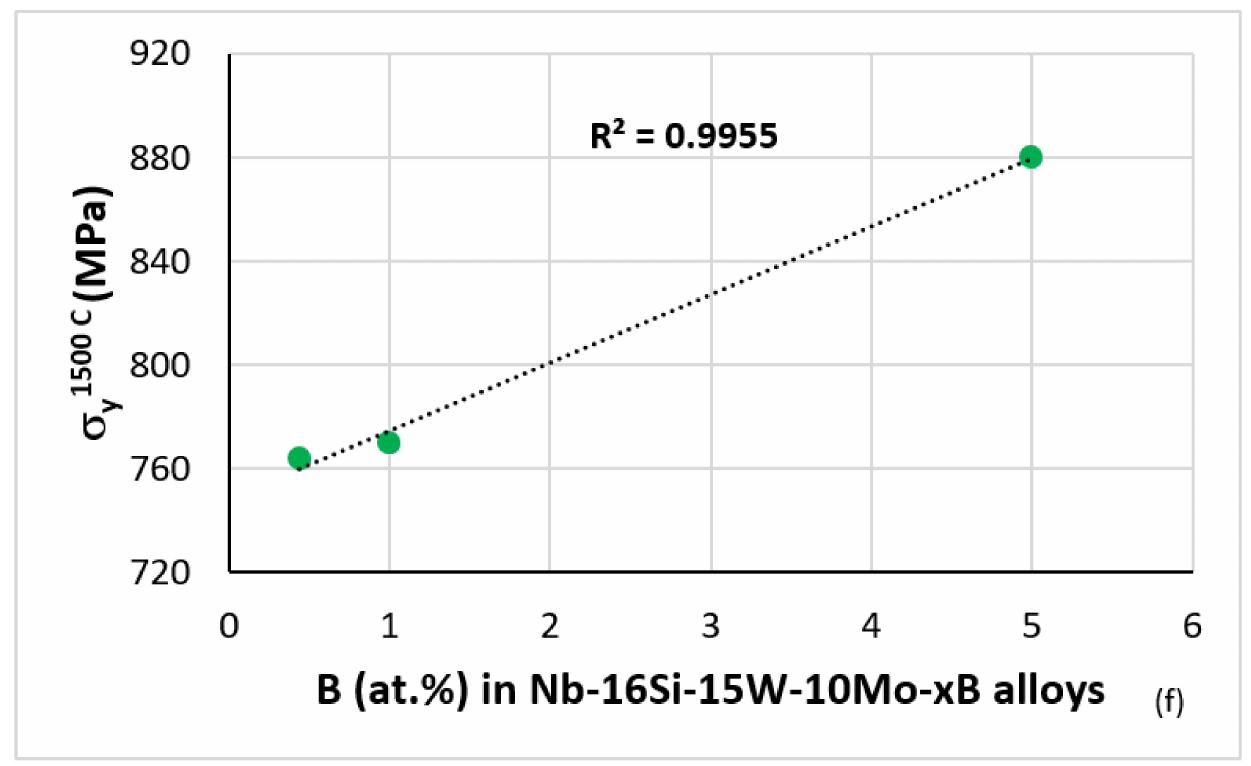
Figure 7. ( a , b ) UTS at 1200 ◦ C of solid solution alloys. ( a ) Nb-xMo (x = 0,7.8,10,12,14.5 at.%) versus VEC. ( b ) Nb-xW (x = 8.2, 11.1, 14.2 at.%) versus W content. ( c ) Minimum creep rate at 1200 ◦ C and 140 MPa versus VEC. ( d ) Rupture life at 1200 ◦ C and 140 MPa versus VEC of solid solution Nb-xW alloys (x = 8.1, 11.5, 14.5, 18 at.%) [29,30]. ( e ) Compressive yield stress at 1200 ◦ C of Nb–10W–10Si– x B alloys (x = 0, 0.1, 1 and 2) [31]. ( f ) Compressive yield stress at 1500 ◦ C of Nb-16Si-15W-10Mo-xB alloys x = 0.44, 1, 5)